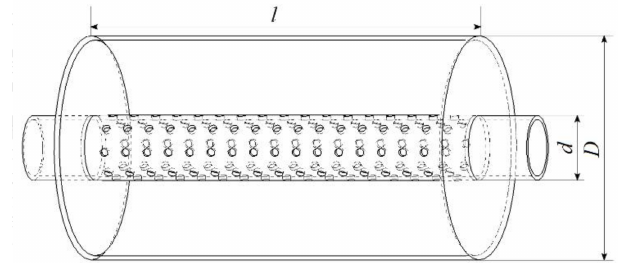
Figure 2. Straight-through perforated tube